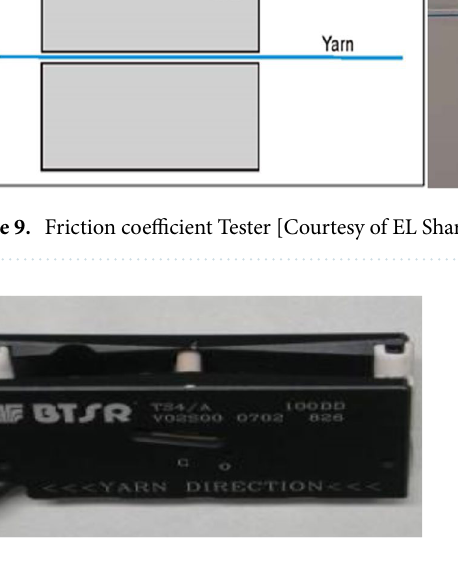
Figure 10. BTSR yarn tension sensor [Courtesy of EL Sharq El Awsat